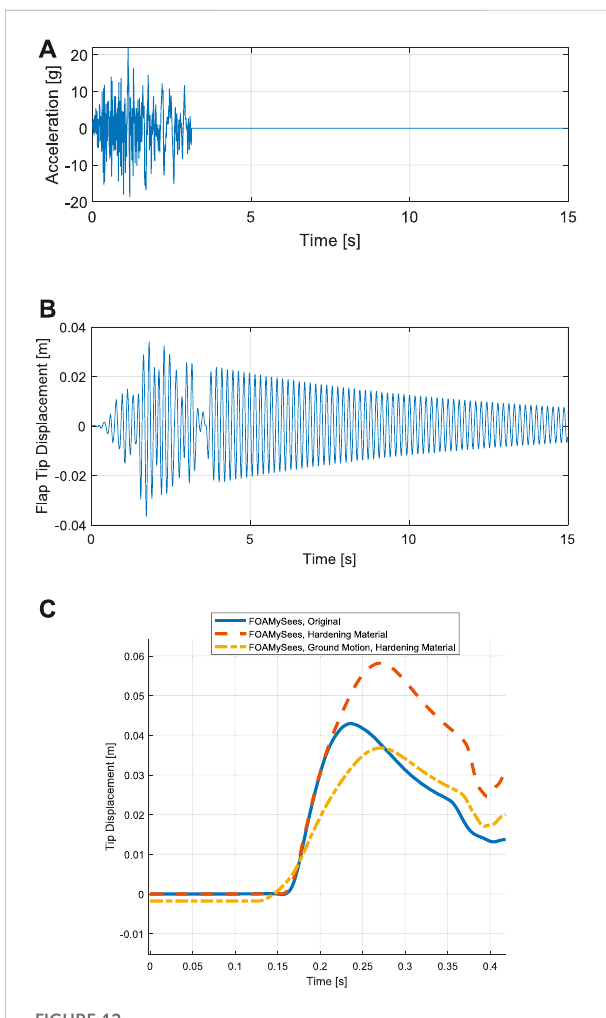
FIGURE 12 (A) ground motion utilized in preliminary seismic analysis (B) fl ap tip displacement resulting from base ground motion excitation prior to fl uid-structure analysis, (C) comparison between FOAMySees Laminar hydrodynamic impact solutions — Demonstration of material hardening effects due to preliminary seismic loading upon fl ap tip